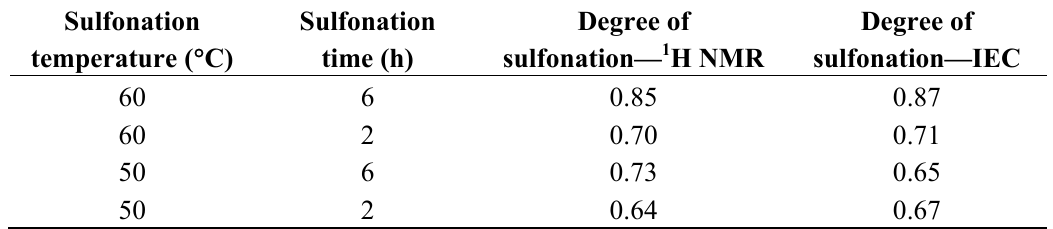
Table 1. Degree of sulfonation as determined by 1 H-NMR and titration.